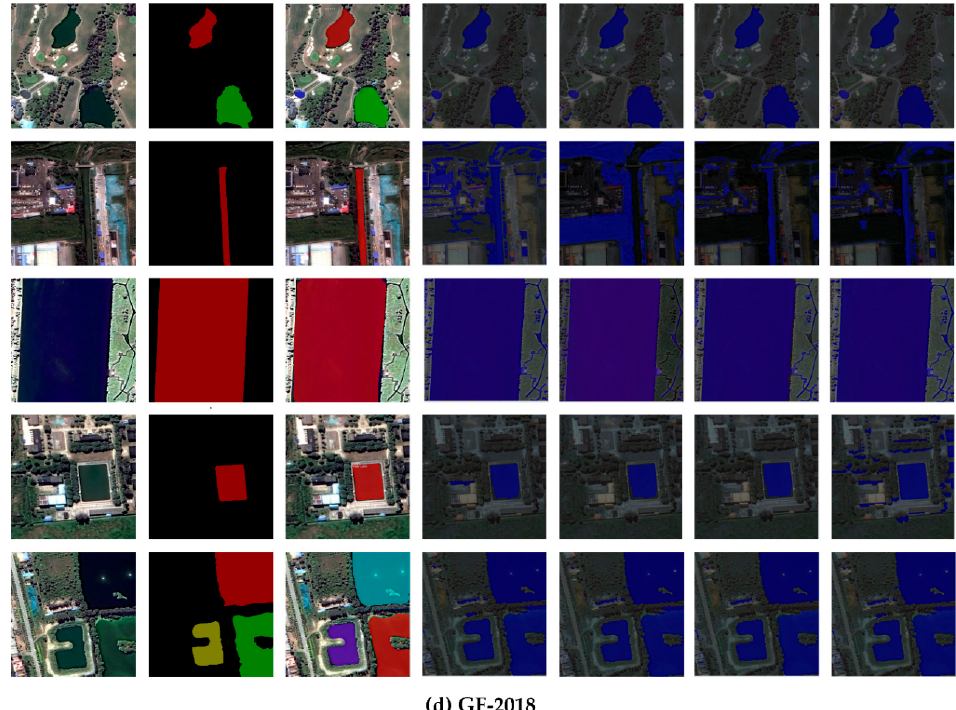
Figure 14. Examples of water recognition results of different methods. From left to right: original image, masks, water recognition results of the Mask R-CNN, Cart, SVM, KNN and Random Trees; From top to bottom: water recognition results of different datasets: ( a ) WV-2014, ( b ) WV-2017, ( c ) GF-2016 and ( d ) GF-2018. Table 8. Water recognition accuracy of different methods in four different test areas.